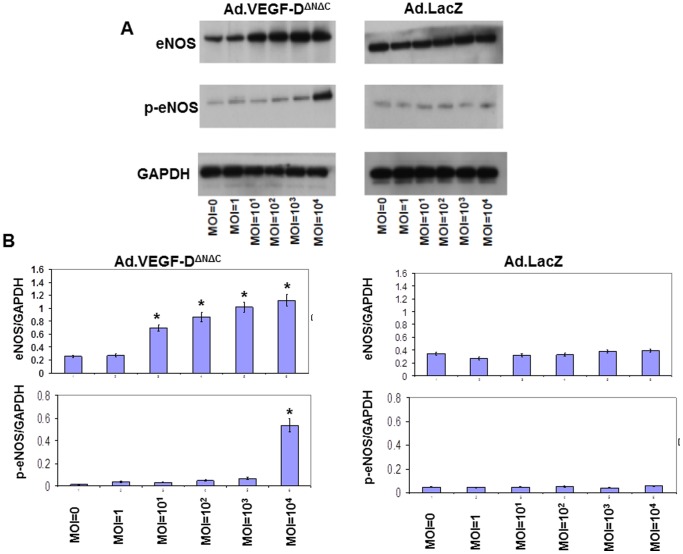
Representative western blots showing an upregulation in eNOS and phospho(p)-eNOS (Ser1177) levels 48 hours after Ad.VEGF-DΔNΔC infection in pregnant sheep UAECs.Pregnant sheep UAECs were grown in culture for up to 4 passages, and then infected at increasing multiplicities of infection (MOIs) with Ad.VEGF-DΔNΔC or Ad.LacZ in 6-well plates. Protein was extracted from infected cells 48 hours later, and assayed for eNOS and p-eNOS (Ser1177) levels by western blotting. (A) An increase in eNOS and p-eNOS (Ser1177) levels with increasing MOI was observed in Ad.VEGF-DΔNΔC infected cells, but not Ad.LacZ infected cells. (B) Densitometric analysis was performed on the eNOS and p-eNOS (Ser1177) bands using Image J software, after normalizing against the density of GAPDH bands. Results are representative of n = 3 independent experiments. * indicates p<0.05 in comparison to the relative density of the corresponding band from uninfected cells (MOI = 0) by t-test.